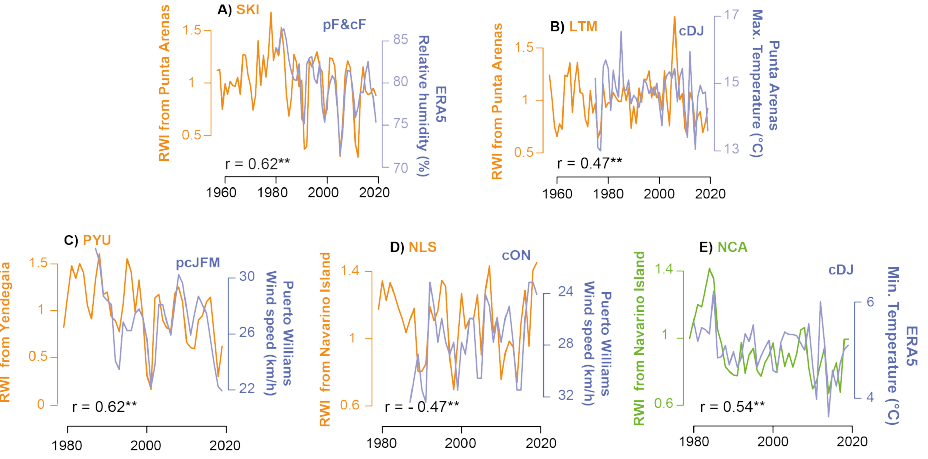
Figure 6. The most significant relationships between ring-width index (RWI) and climate variations at local weather stations and the ERA5 dataset. Significance is indicated for each case: ** = p < 0.01. The best combination of months for the climate-growth correlations were: pF&cF = previous and current February, cDJ = current December to January, pcJFM = previous and current January to March and cON = current October to